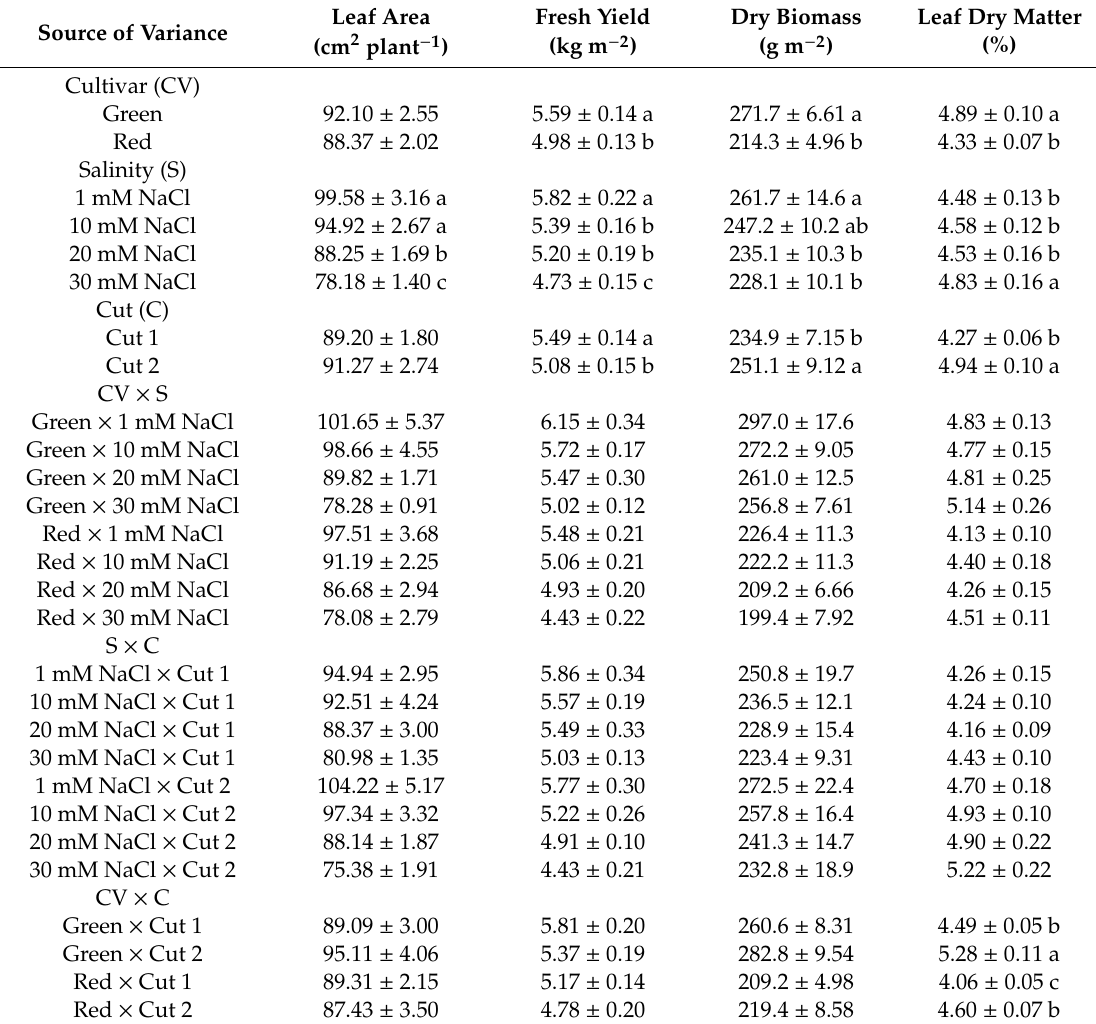
Table 1. Significance of the main factors (cultivar, salinity and cut order) and their interactions on leaf area, total yield, leaf dry biomass and leaf dry matter percentage of Lactuca sativa L. var. acephala grown in a floating raft